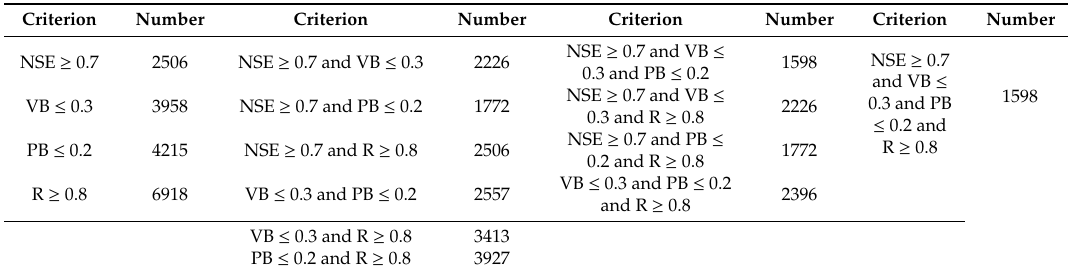
Table 2. Numbers of behavior parameter sets under di ff erent